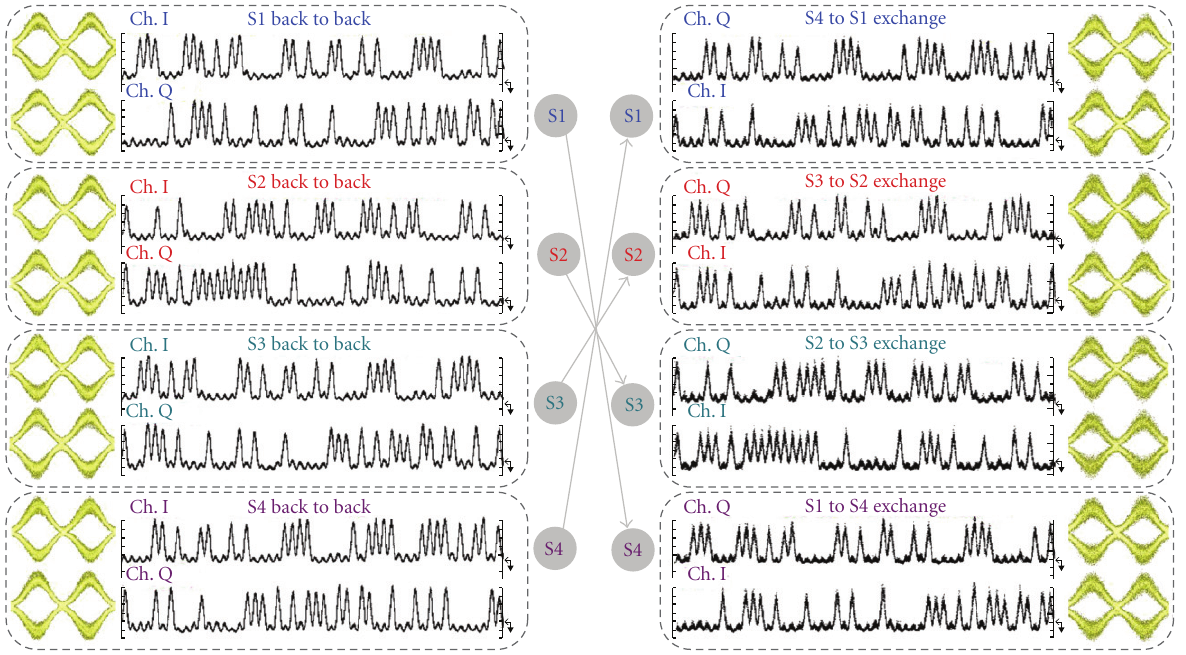
Figure 23: Waveforms and balanced eyes of demodulated in-phase (Ch. I) and quadrature (Ch. Q) components for four-channel 100 Gbit/s DQPSK data